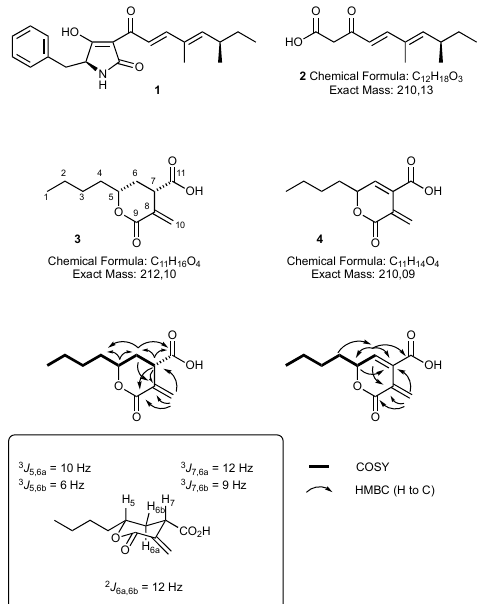
Figure 2. Chemical structures of pretenellin A 1 and the predicted product 2 of the tenellin PKS . Actual structures of oryzine A 3 and B 4 .